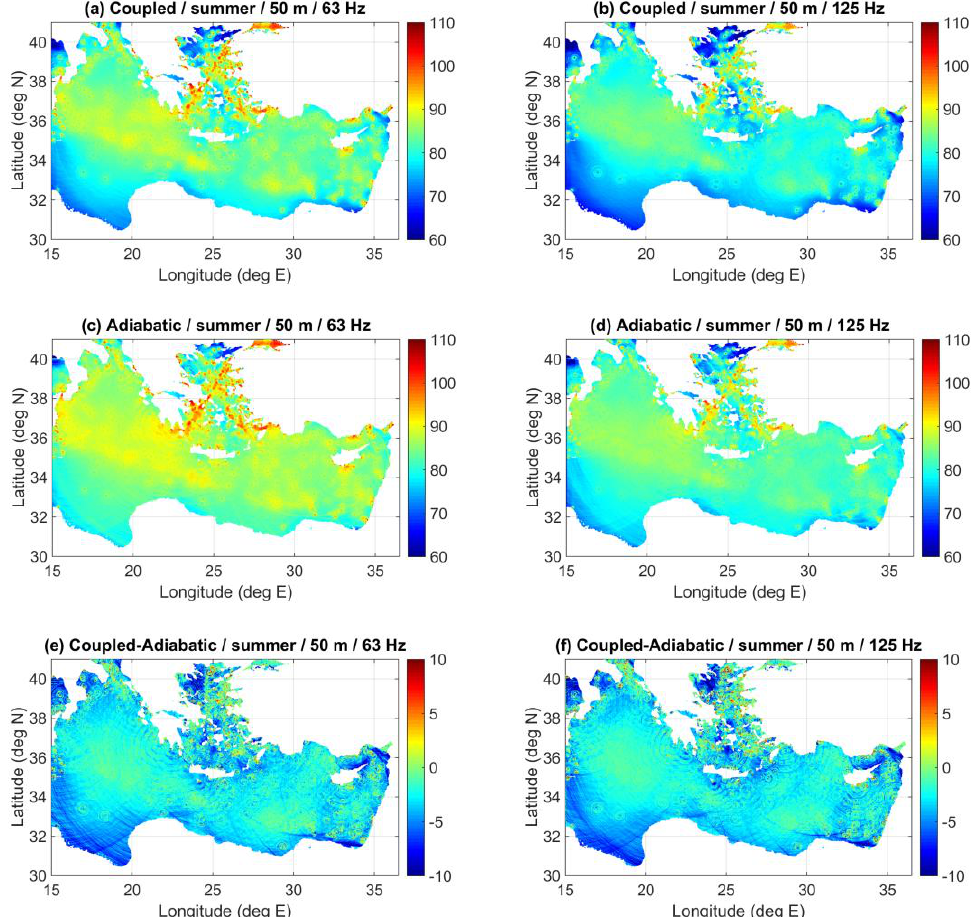
Figure 12. Noise distribution (dB re 1 µ Pa 2 /Hz) in the Eastern Mediterranean Sea at a depth of 50 m for the summer SVP for the source distribution of Figure 10, assuming all sources at 5 m depth, with spectral source levels of 165 dB re 1 µ Pa 2 /Hz @ 1 m at 63 Hz and 155 dB re 1 µ Pa 2 /Hz @ 1 m